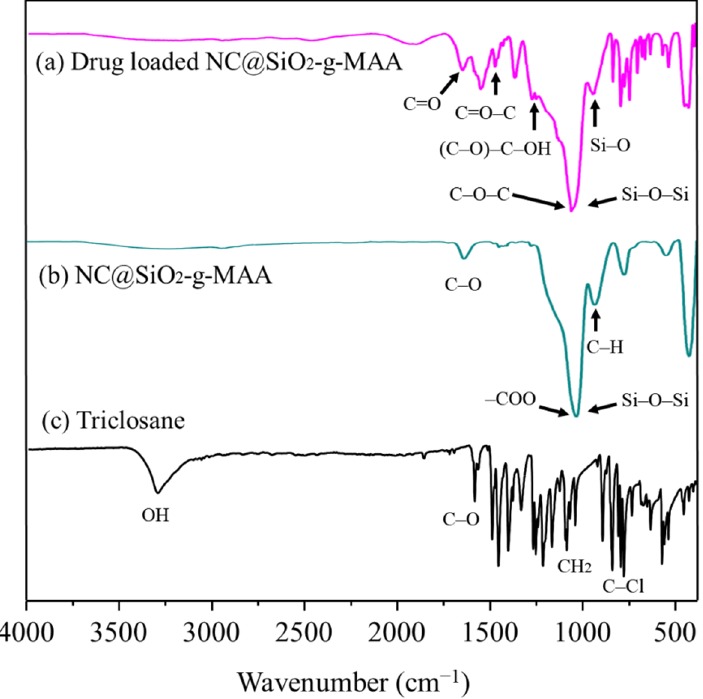
Figure 5. The FT-IR spectra for the ( a ) drug-loaded NCs, ( b ) pristine NCs and ( c ) triclosan